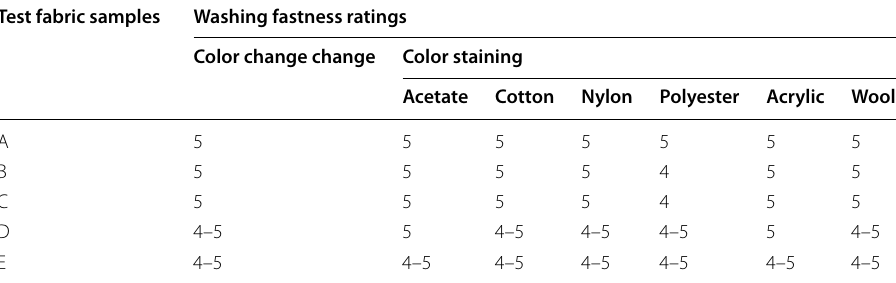
Table 4 Colorfastness to perspiration (color change and color staining) of henna dyed pol- yester fabric samples